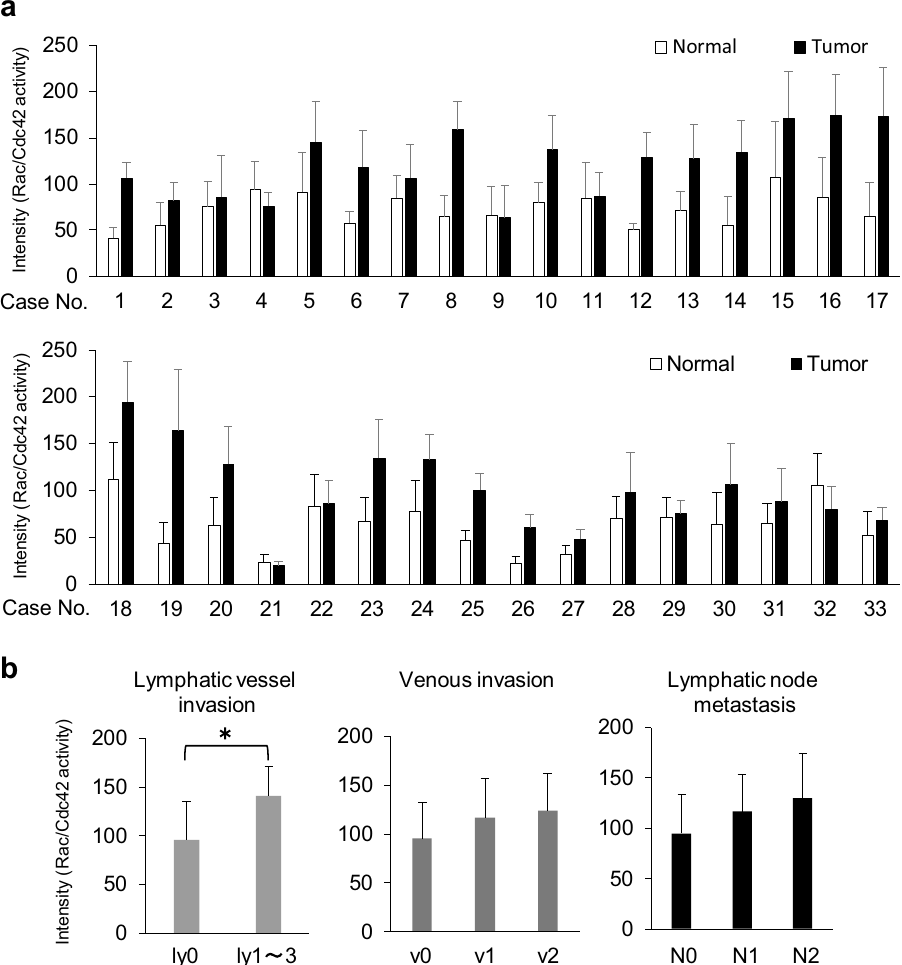
Figure 5. Immunostaining for active Rac and Cdc42 was performed in tissue microarray (TMA) samples from 33 patients with colon cancer. ( a ) DAB intensities showing Rac/Cdc42 activity in the tumor area and normal mucosa were measured using Histoquest software and graphed as the means ± SD. ( b ) Correlations between Rac/Cdc42 activity and lymphatic vessel invasion (left), venous invasion (middle), and lymph node metastasis (right) were analyzed and graphed as the means ± SD. * P <